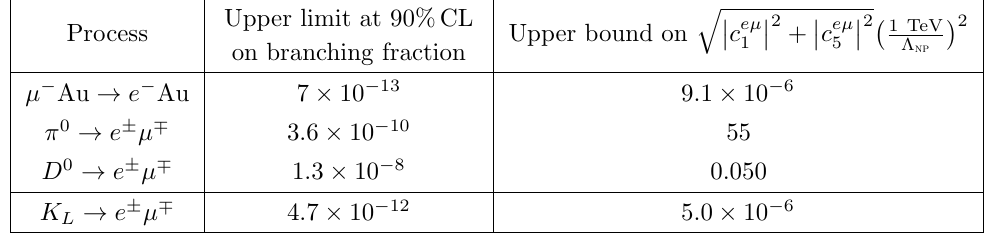
= c (cid:22)e if these coe(cid:14)cients are real and 1 ; 5 1 ; 5